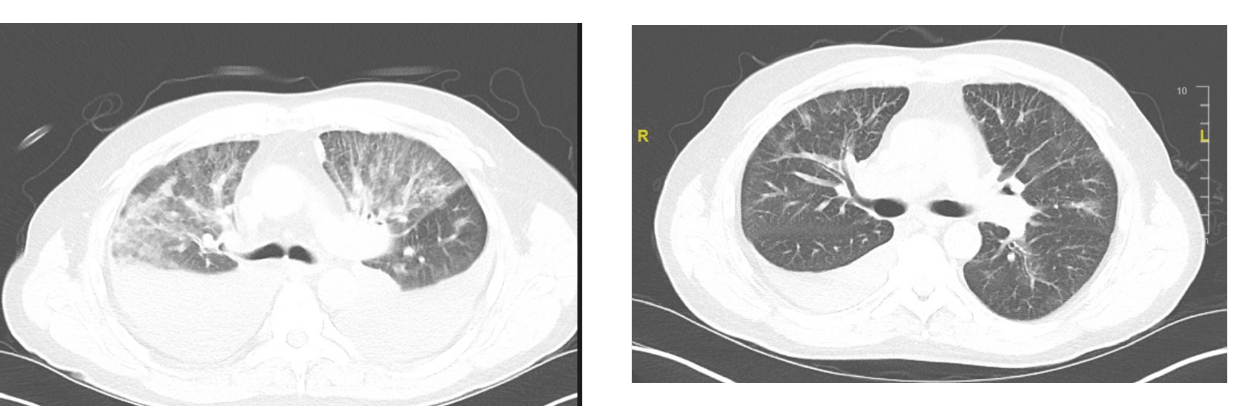
Figure 2: Repeat CT thorax without contrast showing moderate- sized right pleural effusion with right lower lobe